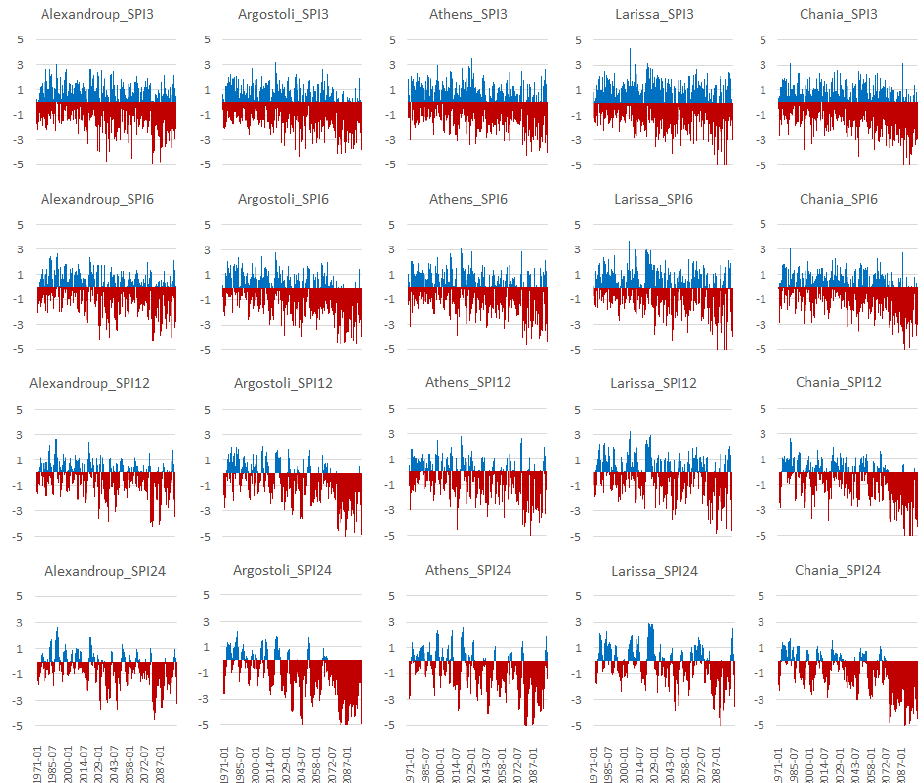
Figure 14. Standardized precipitation index estimates for five Greek stations at scales of three (SPI3), six (SPI6), twelve (SPI12), and twenty-four (SPI24) months. The graphs display the temporal variation of SPI over 1971–2100 under RCP8.5.